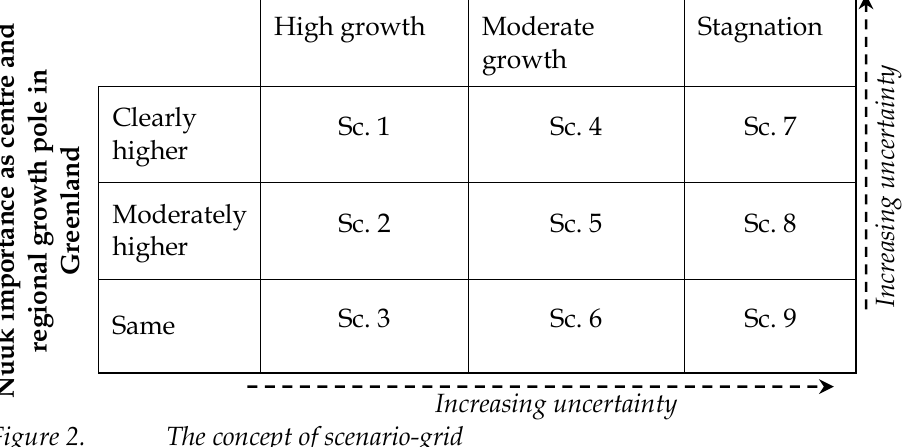
Figure 2. The concept of